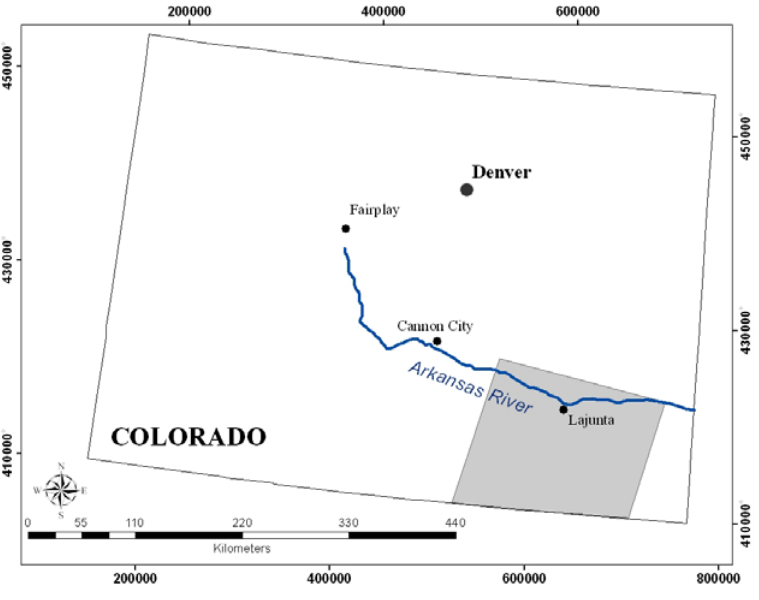
Figure 1. Map of the Arkansas River in Colorado. The study area is highlighted in